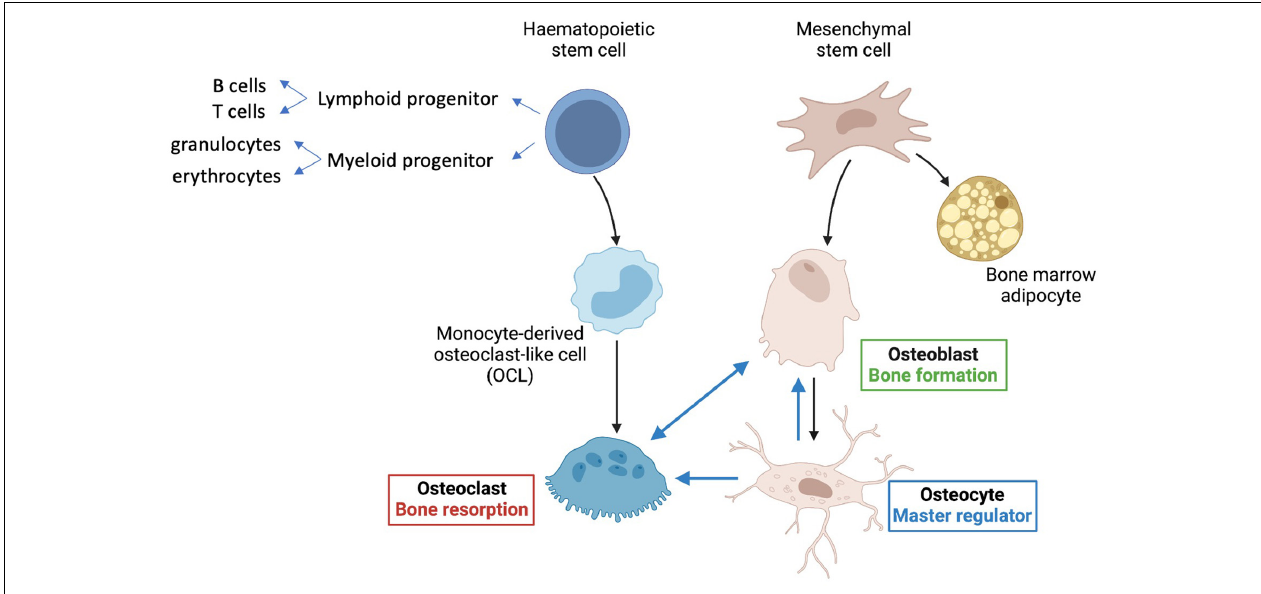
FIGURE 1 | Key cell types in bone. Hematopoietic stem cells (HSCs) give rise to lymphoid progenitors that lead to formation of B and T cells. Myeloid progenitor cells give rise to all classes of granulocytes, monocytes, and red cell precursors (erythroblasts), as well as osteoclasts, via monocyte derived osteoclast-like cells (OCLs). Mesenchymal stem cells (MSCs) predominantly give rise to bone-forming osteoblasts, osteocytes, and also bone marrow adipocytes. The longest-lived cells in bone are the osteocytes, which regulate formation of both osteoclasts and osteoblasts and are major contributors to mineralization (see text for details).